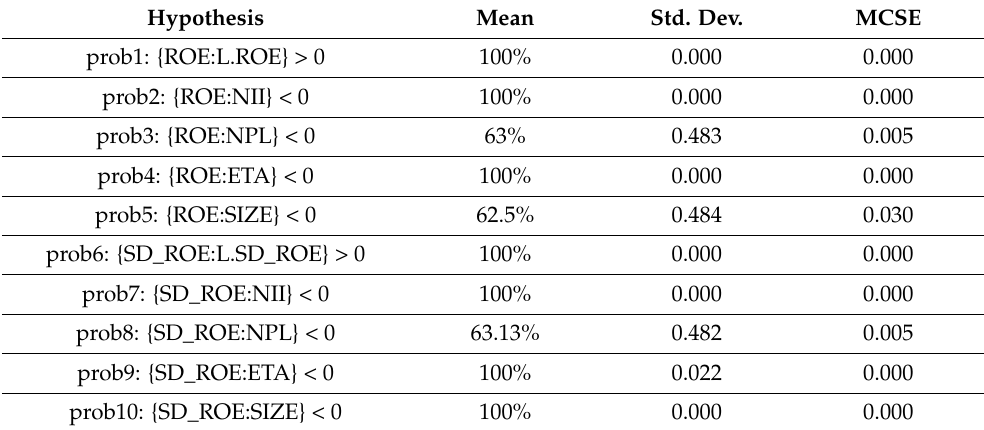
Table 6. Probability of regression